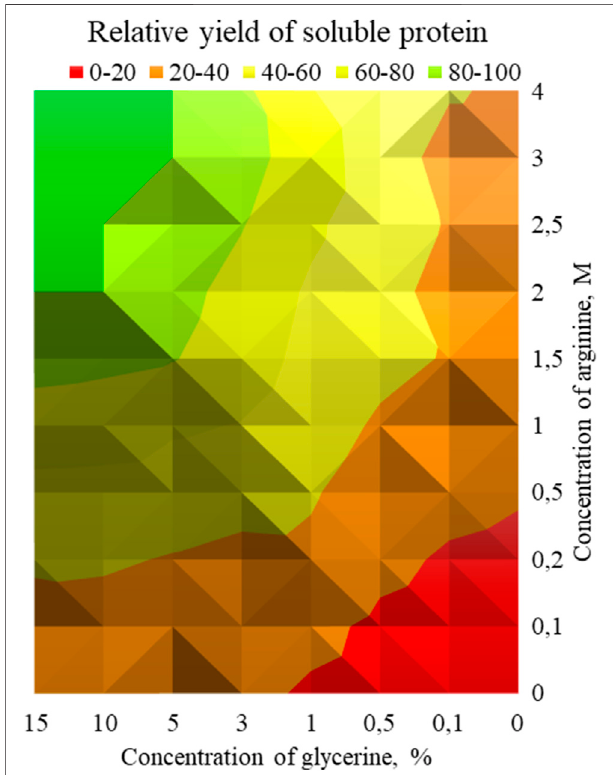
FIGURE 3 | - Dependence of chitinase activity on the concentration of arginineand glycerol.Greenzone — concentrations ofglyceroland arginine, at which the maximum relative yield of active soluble protein was reached after refolding (80 – 100%), yellow-green zone (60 – 80%), yellow zone (40 – 60%), orange zone (20 – 40%) and red zone (0 –